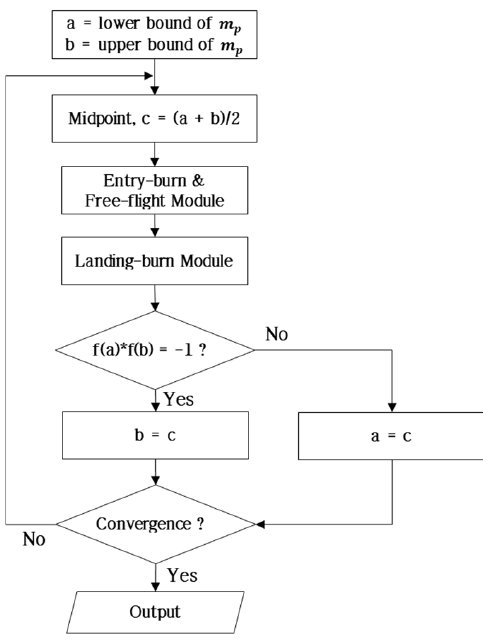
Figure 2. Calculation process of the minimum required propellant weight.